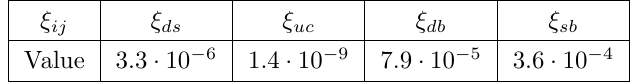
Table 6 . Numerical values of (cid:24) ij constants in e(cid:11)ective Lagrangian